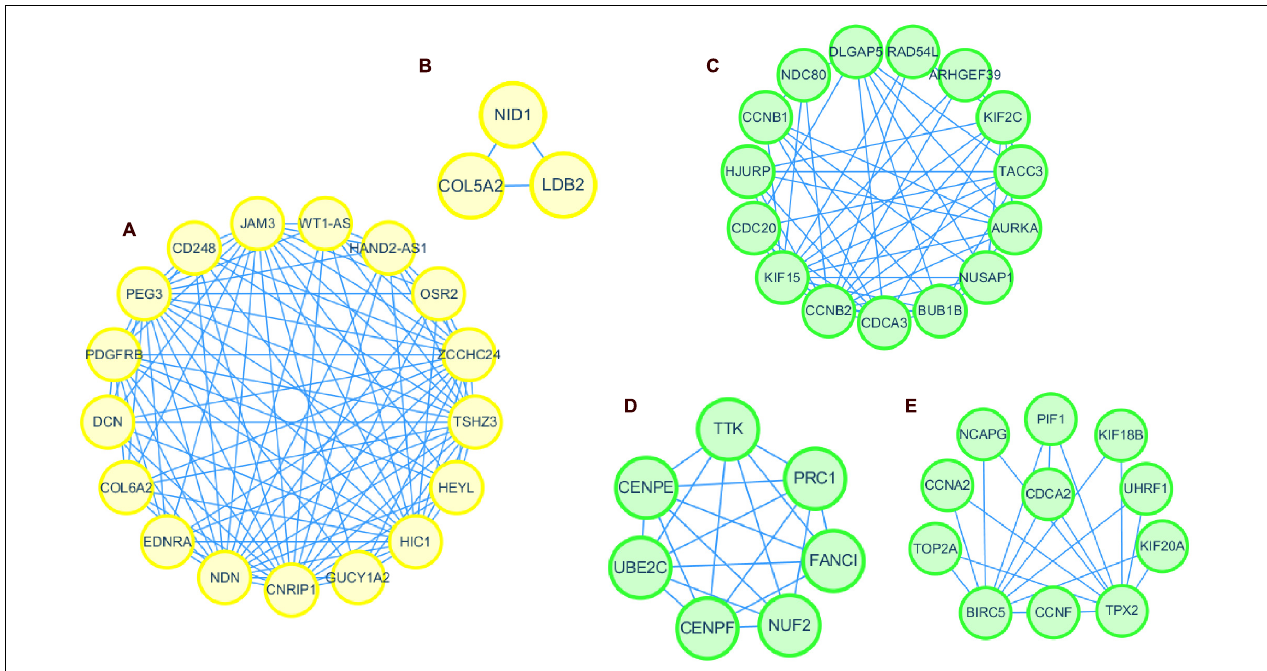
FIGURE 6 | Protein interaction network of genes in clusters identified by MCODE in Cytoscape. Clusters 1 and 2 formed the yellow module (A,B) . Clusters 1, 2, and 3 formed the green module (C–E) .